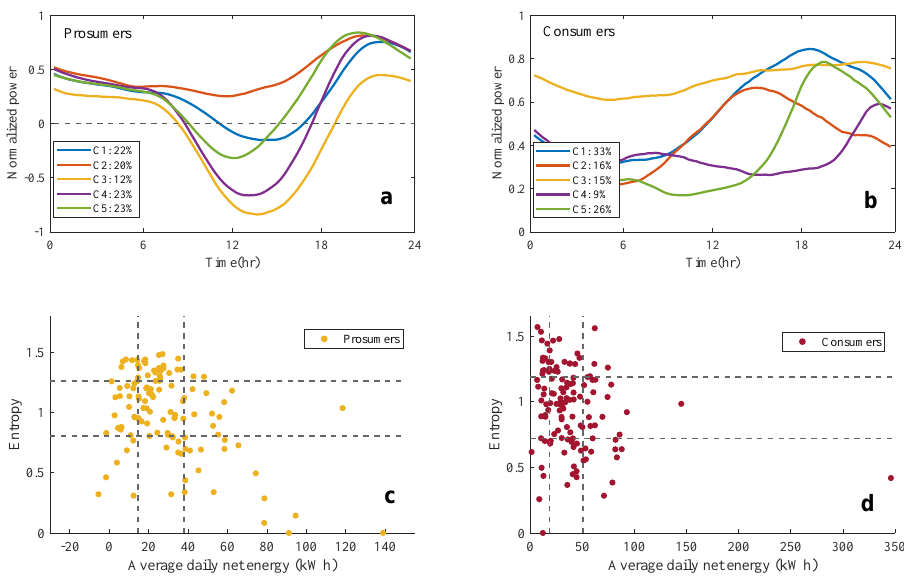
Figure 6. Clustered net energy profiles of prosumers and consumers and their entropy distribution: ( a ) clusters of prosumers’ daily profiles, ( b ) clusters of consumers’ daily profiles, ( c ) entropy of prosumer households, and ( d ) entropy of consumer households. Values in the legend for subplot ( a , b ) show the frequencies of clusters in the